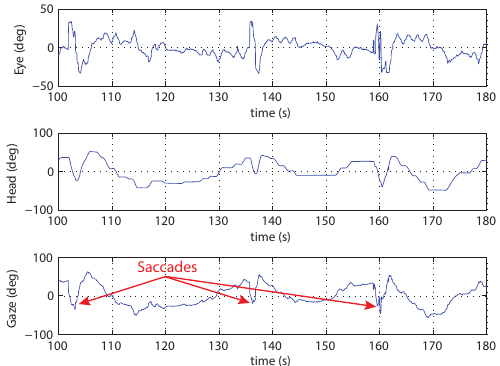
Figure 25. Saccades generated by the eye tracking/gimbal system.